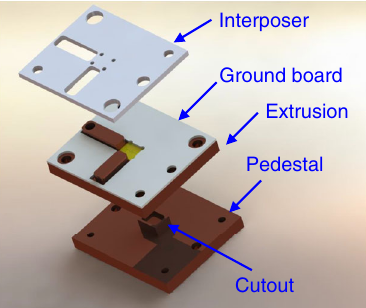
Fig. 6 Illustration of the directional coupler package. It displays the different layers of the pogo-package used for housing the wideband, superconducting directional coupler. The pogo-package is used to provide 50 Ω matched vertical transitions between the directional coupler chip and